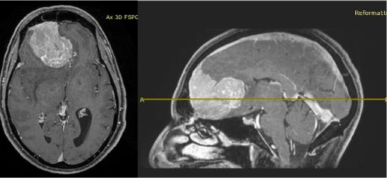
Figure 1. Pre-operative brain MRI showing the anterior cranial fossa meningioma with perilesional oedema.